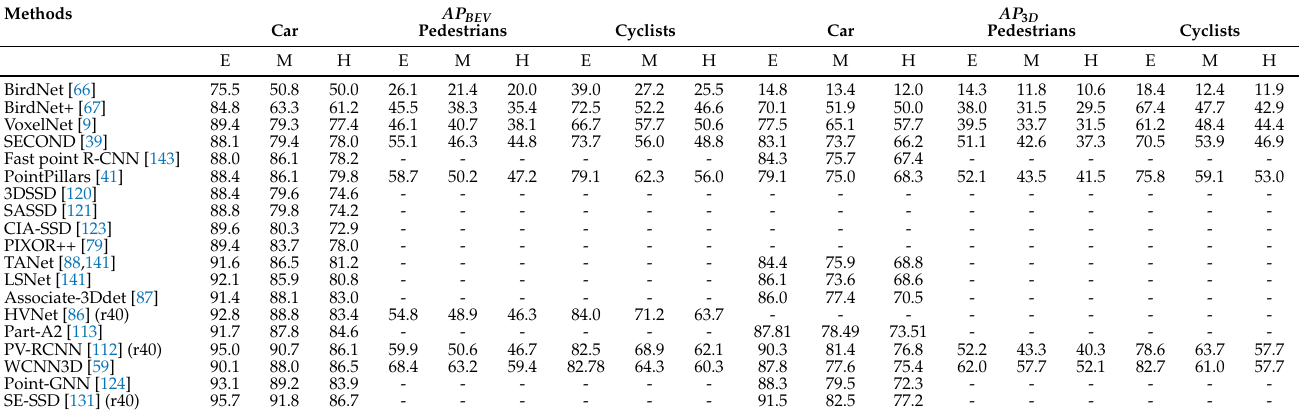
Table 1. BEV and 3D performance comparison (%) of selected LiDAR-based 3D object-detection methods on the KITTI [52] test benchmark. r40 shows the mAP is calculated for 40 recall points instead of 11. E stands for easy, M for moderate, and H for hard.